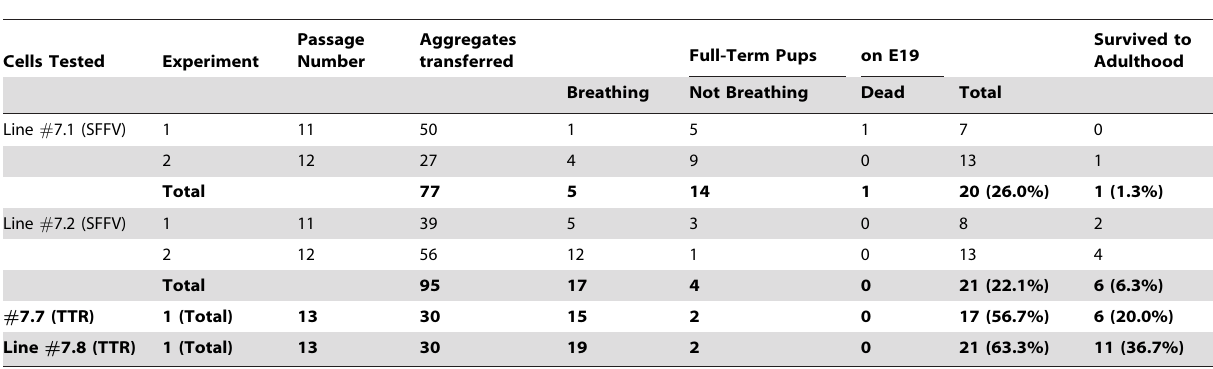
Table 2. Experimental summary of FAH gc -iPS cell tetraploid complementation.